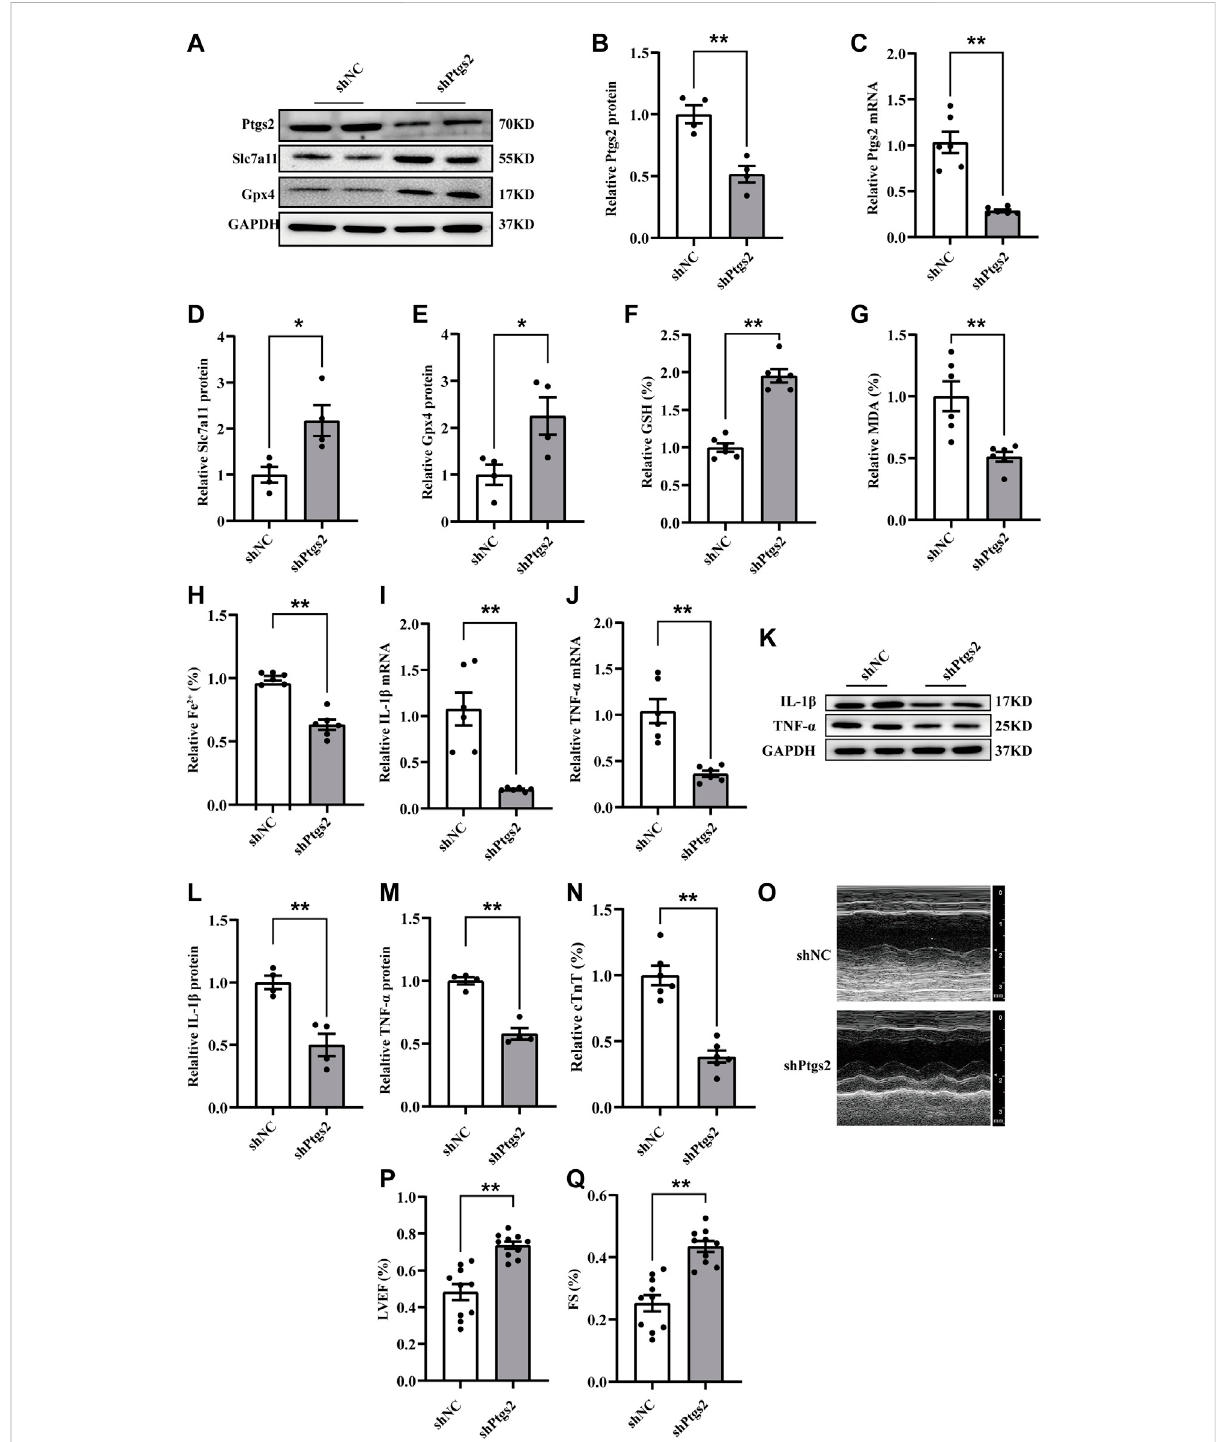
FIGURE 3 Ptgs2silencingamelioratedferroptosis-mediatedmyocardialinjuryandin fl ammationfollowingCME. (A – C) Theef fi ciencyofPtgs2 silencingin mRNA ( n = 6) and protein ( n = 4) level. (D,E) The expression levels of Gpx4 and Slc7a11 determined by western blotting ( n = 4). (F – H) Levels of GSH, Fe 2+ , and MDA in myocardial tissues ( n = 6). (I,J) The mRNA levels of TNF- α and IL-1 β in each group ( n = 6). (K – M) Western blotting showing the expression of IL-1 β and TNF- α ( n = 4). (N) Serum levels of cTnT were decreased in the shPtgs2 group ( n = 6). (O – Q) Cardiac LVEF and FS detected by echocardiography ( n = 10). GAPDH served as an internal control was performed to quantitatively normalized the protein data. Data are presented asthenormalizedmean±SEM (toshNC)ormean ±SEM.Values inshNCswereaveragedand normalized to1 (A – N) .* p < 0.05. ** p < 0.01. CME: coronary microembolization; LVEF: left ventricular ejection fraction; FS: fractional shortening; cTnT: cardiac troponin T; Gpx4: glutathione peroxidase4;Slc7a11:solutecarrierfamily7member11;Ptgs2:prostaglandin-endoperoxidesynthase-2;MDA:malondialdehyde;GSH:glutathione; IL-1 β : interleukin 1 beta; TNF- α : tumor necrosis factor